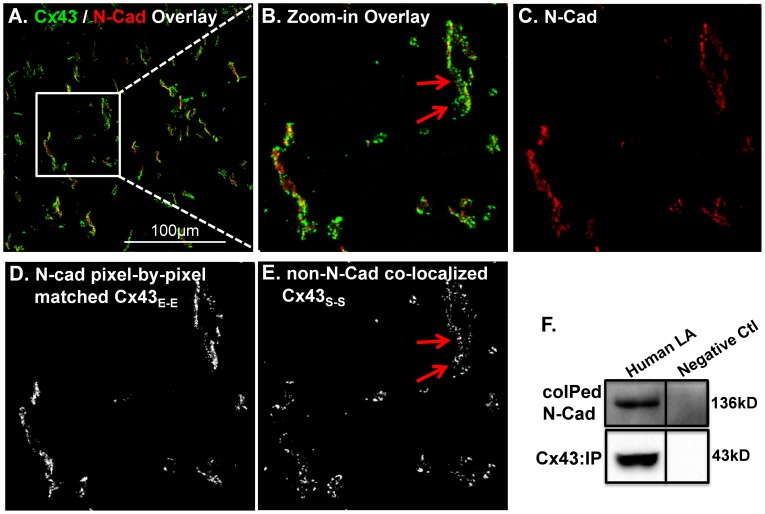
Interaction between Cx43 and N-Cad proteins in human LA.
A. Representative double immunostaining image of Cx43 (green) and N-Cad (red). B-E. Enlarged images from a cropped area of image A including the Cx43/N-Cad overlay image (B), N-Cad (red; C), N-Cad pixel-by-pixel matched Cx43 signals (D), and non-N-Cad co-localized Cx43 (E). Arrows indicate stellate Cx43 pixels are in close proximity with the N-Cad pixel but do not pixel-by-pixel co-localize with N-Cad. F. Immunoblotting images of co-immunoprecipitated N-Cad protein with immunoprecipitated Cx43 proteins. Right column is the immunoprecipitated negative control without primary Cx43 antibody.